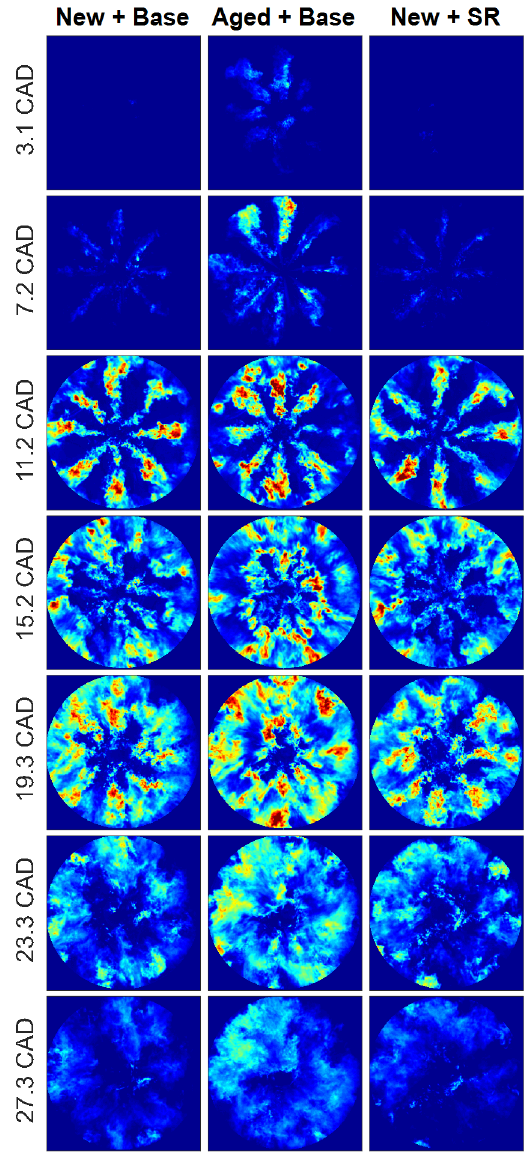
Figure 17. Natural luminosity signal during combustion processes at low load when using different fuels with different injectors.